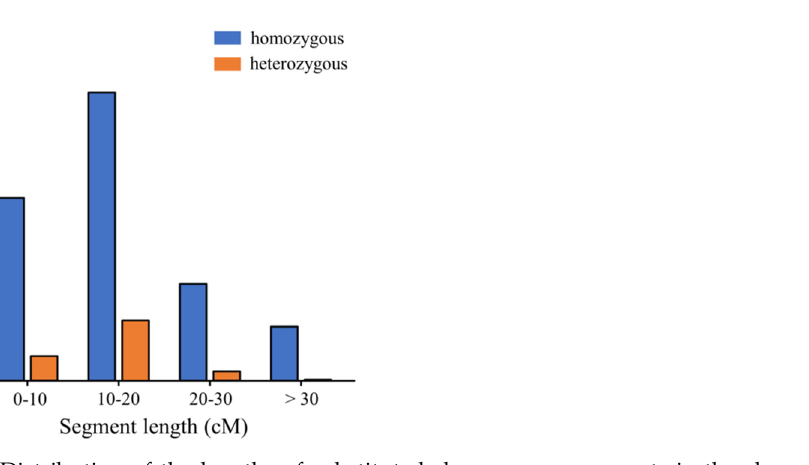
Figure 4. Survival rates of chromosome segment substitution line seedlings subjected to 200 mM NaCl stress. The data represents the average of two independent experiments. 3.4. SNP Chip Assay To confirm the results of QTL mapping, five CSSLs (CSSL77, 104, 128, 134, and 201) with strong salt stress tolerance were selected for further SNP detection via whole-genome SNP chip screening. SNP genotyping was performed using an Illumina GSR40K SNP chip containing 44,263 SNPs. We accordingly screened out a total of 32,887 high-quality SNP loci for further analysis, of which 32,595 had positional coordinates. Given that the heterozygous genotypes of parents will segregate among their offspring and that it is not possible to trace their origins, we thus used differential homozygous loci